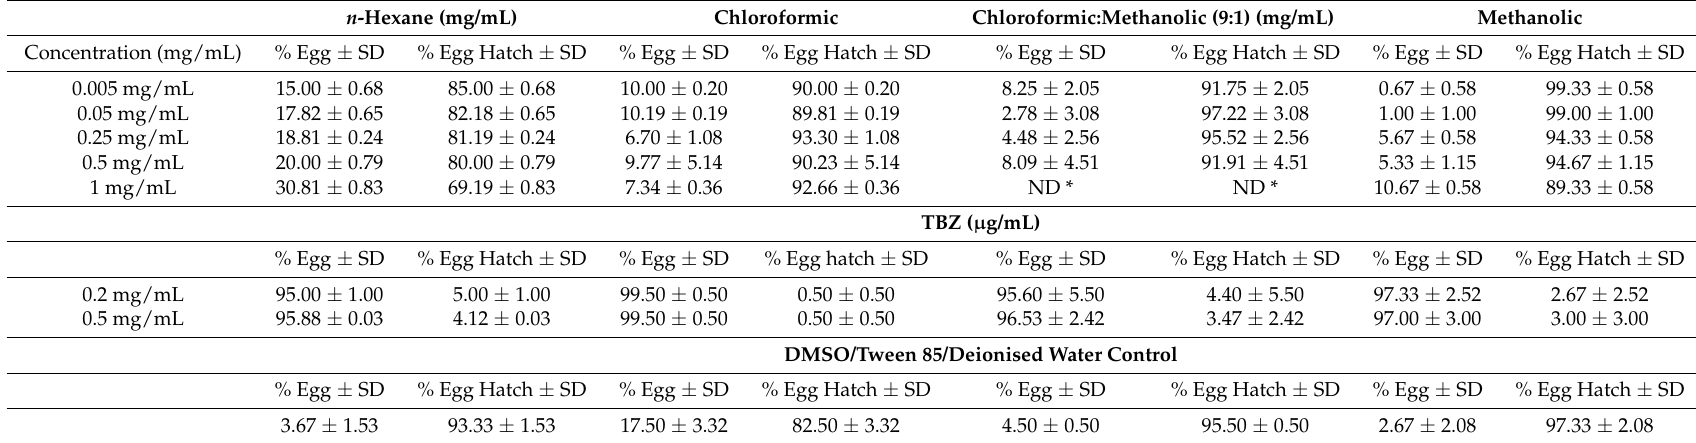
Table 1. Percentages of gastrointestinal nematode (GIN) eggs and egg hatch after treatment at various concentrations with thiobendazole, leaf n -hexane, chloroformic, chloroformic:methanolic (9:1) and methanolic extract of H. forskaolii and deionised water. n -Hexane (mg/mL) Chloroformic Chloroformic:Methanolic (9:1) (mg/mL)